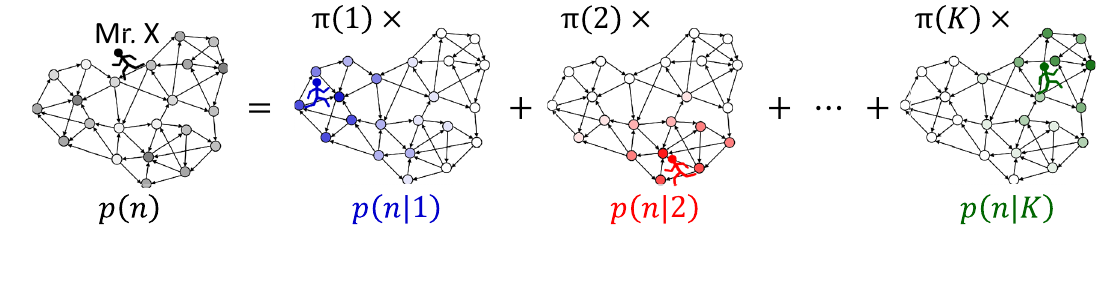
K 1 π( k ) p ( n | k ) . The probability p ( n ) that Mr. X is at k = = (cid:31)